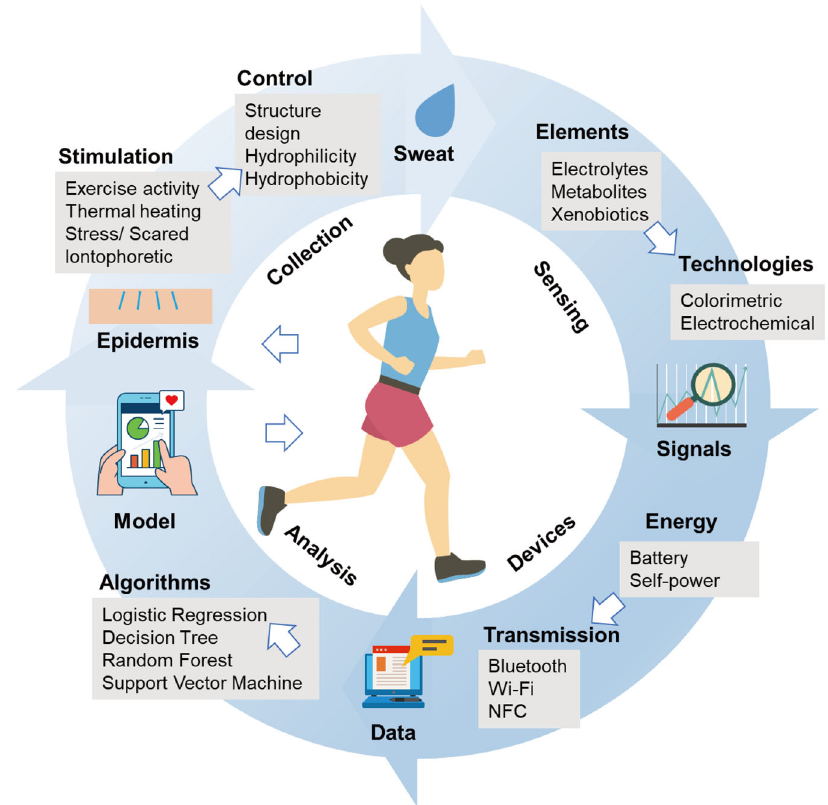
Fig. 2 Wearable sweat sensors system. Different stages of the process from sweat production to human state